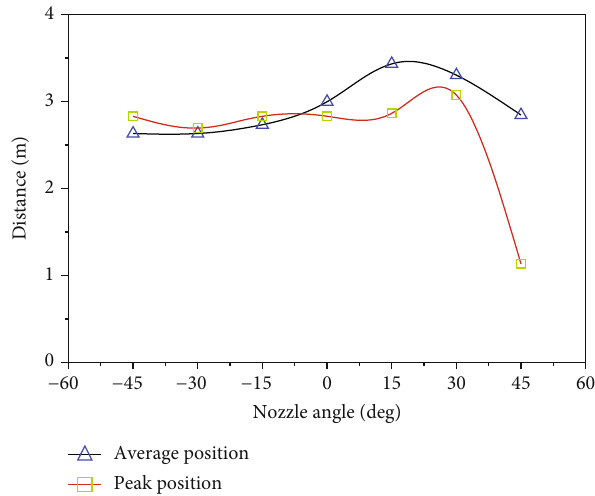
Figure 13: The drift distance for di ff erent nozzle angles in hover state when velocity is 3